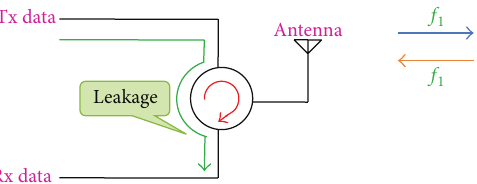
Figure 2: Self-interference in the single-channel full-duplex single- antenna wireless communications.